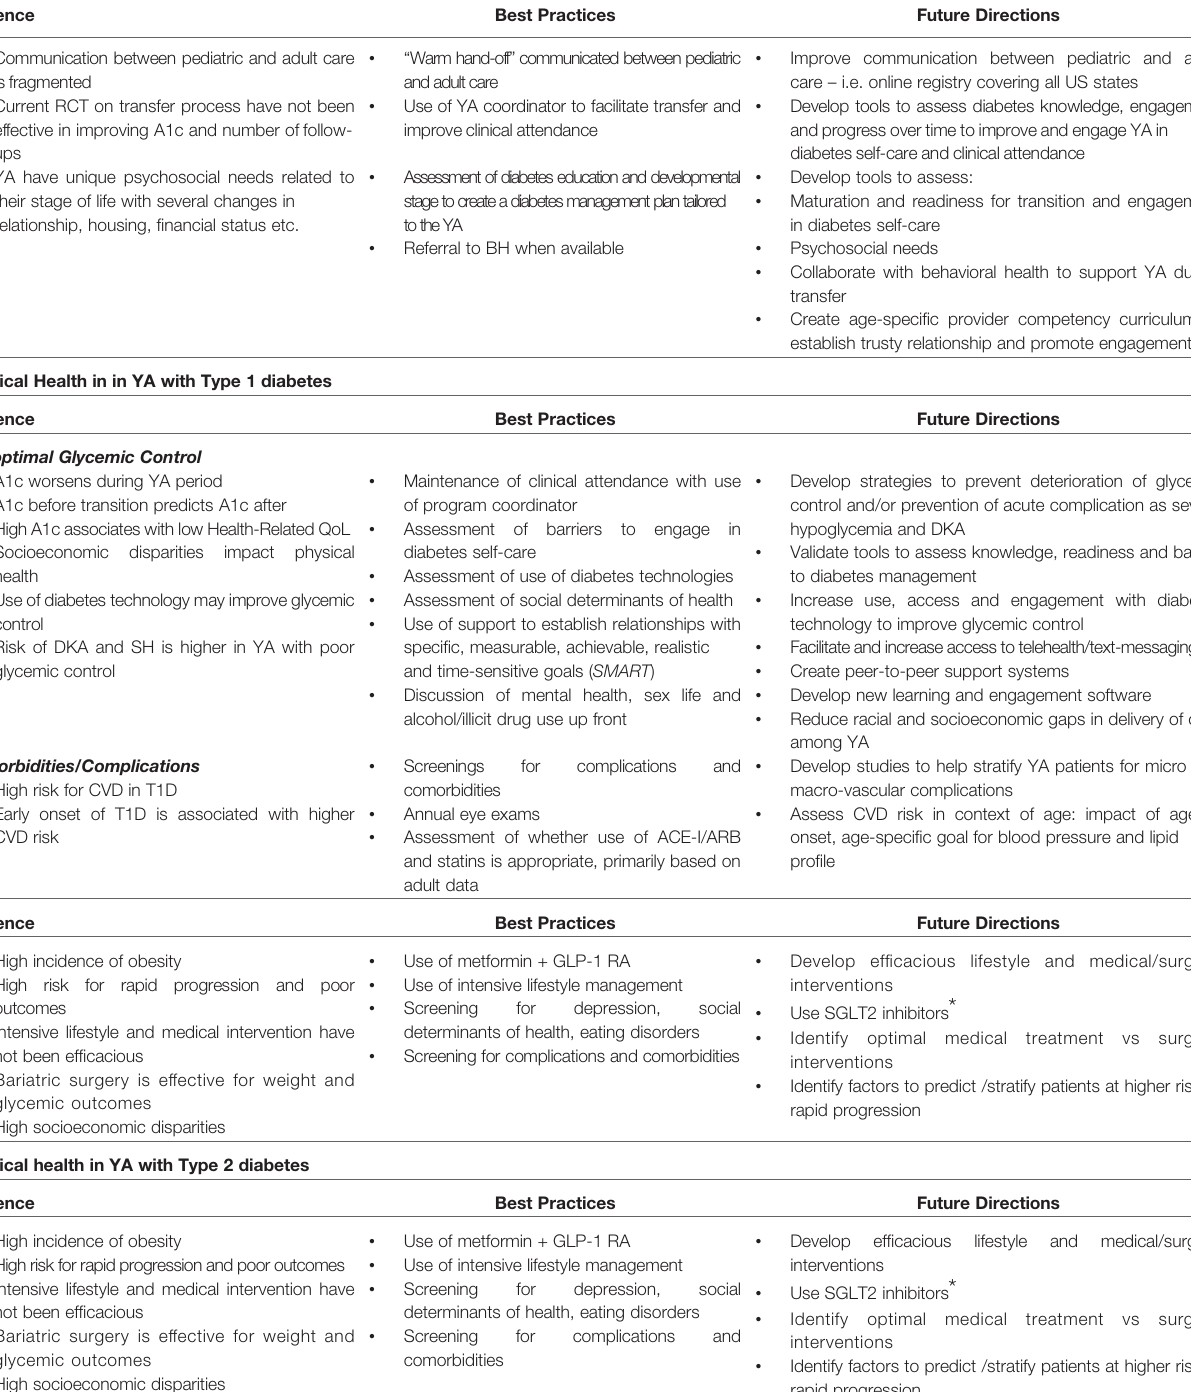
TABLE 1 | Evidence, best practices, and future direction to improve the care of Young Adults with diabetes in adult care setting. The process of transfer from pediatric to adult healthcare systems Evidence Best